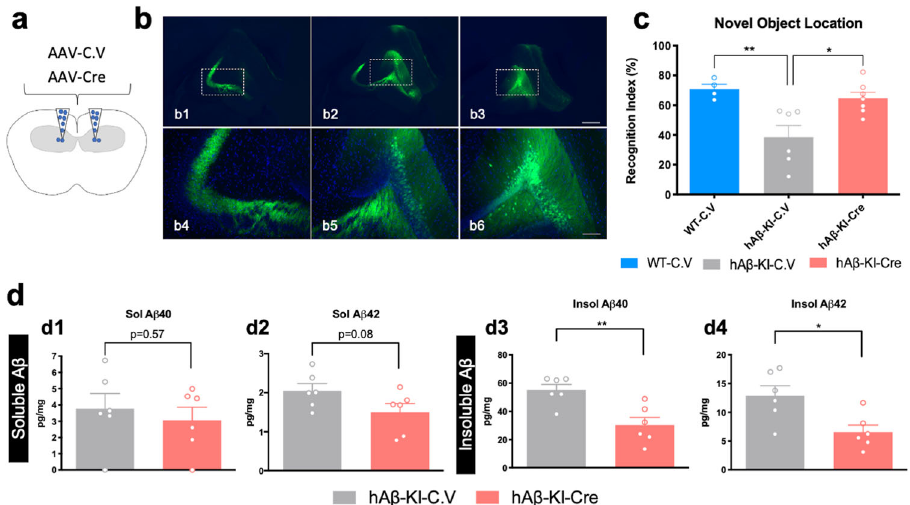
Fig. 6 Cre-mediated deletion of A β encoding exon ameliorates the hippocampal memory de fi cits in hA β -KI mice. a Schematic diagram of AAV delivery in the hippocampus (coronal section). b Representative images of AAV-CAMKII-GFP construct expression in the hippocampus. c Cognitive performance (OLM) of 25-mo WT and hA β -KI homozygous mice treated with control AAV-CAMKII and experimental AAV-CAMKII-Cre vectors (One-way ANOVA, F 2,14 = 5.971; Tukey ’ s post hoc test, * p < 0.05 and ** p < 0.01)) (blue = WT-C.V, gray = hA β -KI-C.V and red = hA β -KI-Cre). ( n = 4 in WT-C.V, n = 6 in hA β -KI-C.V and n = 7 in hA β -KI-Cre). d Hippocampal A β 40 and A β 42 was quanti fi ed by MSD V-PLEX Plus A β Peptide Panel 1 (6E10) Kit ( n = 6/ genotype/treatment) (gray = hA β -KI-C.V and red = hA β -KI-Cre), showing a signi fi cant decrease in soluble A β 40 (unpaired, two-tailed t -test, p = 0.057) and A β 42 (unpaired, two-tailed t -test, p = 0.08) and insoluble A β 40 (unpaired, two-tailed, t -test ** p = 0.0042) and A β 42 (unpaired, two-tailed t -test, * p = 0.0149) in hA β -KI-Cre compared to hA β -KI-C.V mice. Data are presented as mean values ± SEM. Scale bar: 400 μ m (b1 – b3), 100 μ m (b4 – b6).